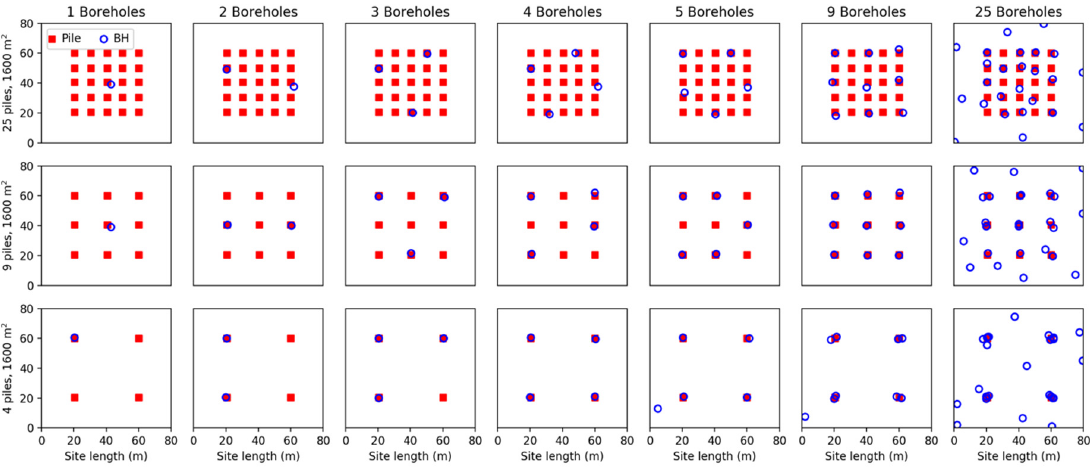
Figure 5. Optimal testing locations for di ff erent numbers of piles and boreholes for a soil with a COV of 80% and an SOF of 20 m.